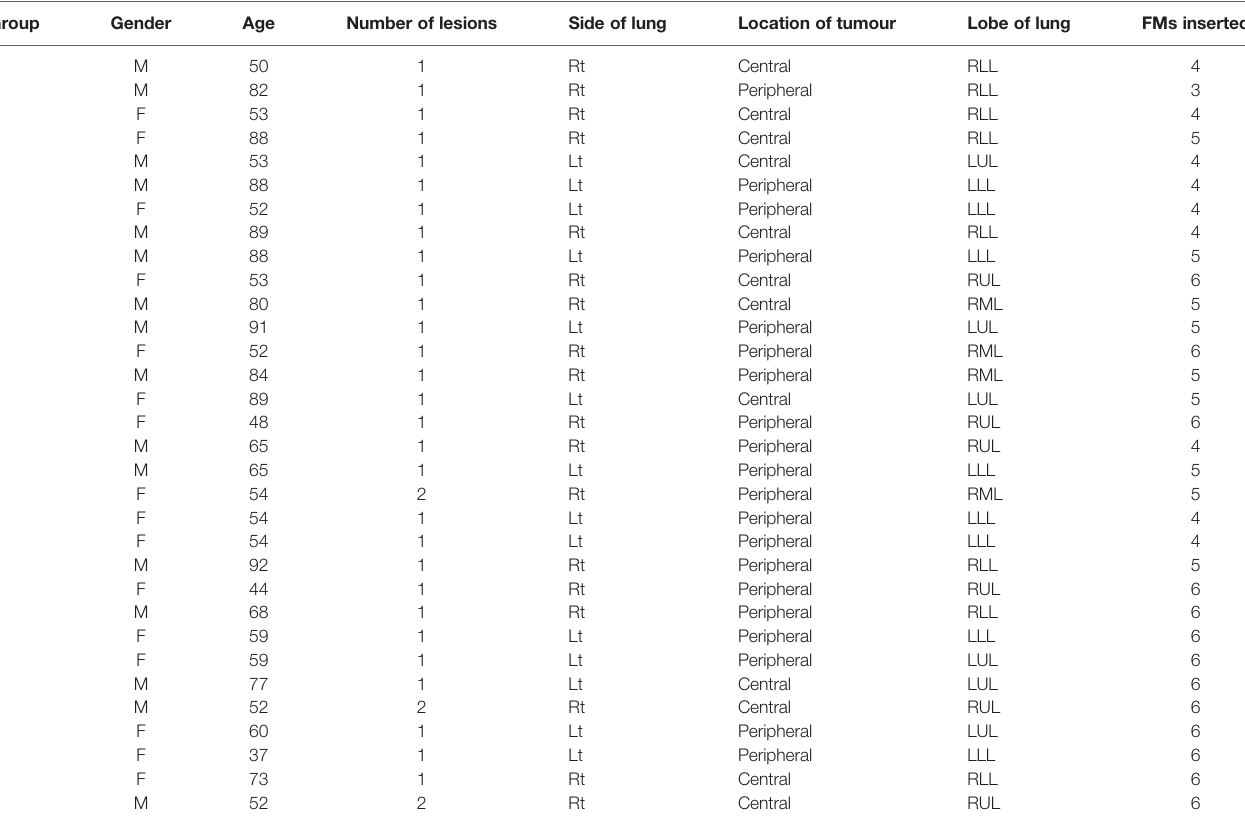
FMs, fi ducial markers; RLL, right lower lobe; LUL, left upper lobe; LLL, left lower lobe; RUL, right upper lobe; RML, right middle